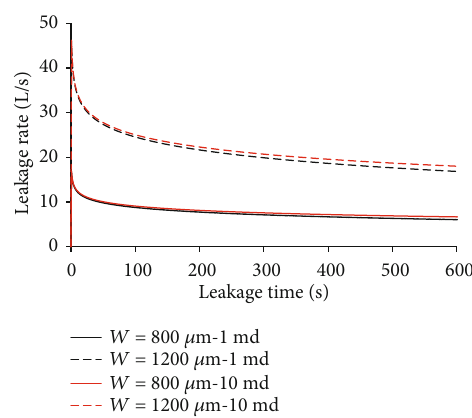
Figure 21: Leakage volume under di ff erent formation permeability and well bottom di ff erential pressure.